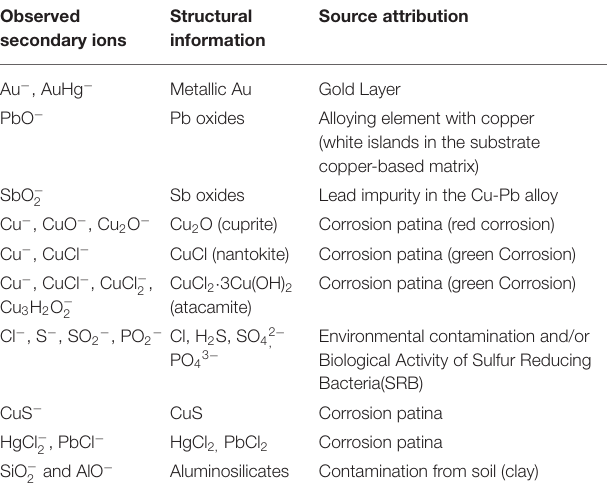
TABLE 1 | Correspondence among observed secondary ions, structural information, and source attribution in the object/environment system. Observed Structural secondary ions